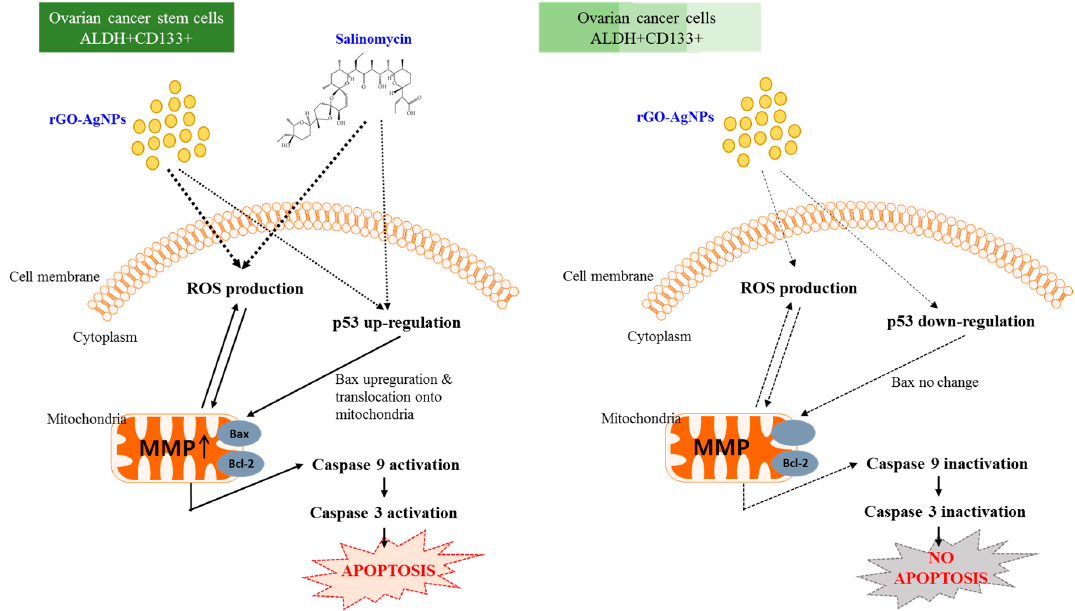
Figure 10. Hypothetical model explaining the working mechanism of rGO–Ag and salinomycin to induce toxicity and apoptosis in ovarian cancer cells and OvCSCs.